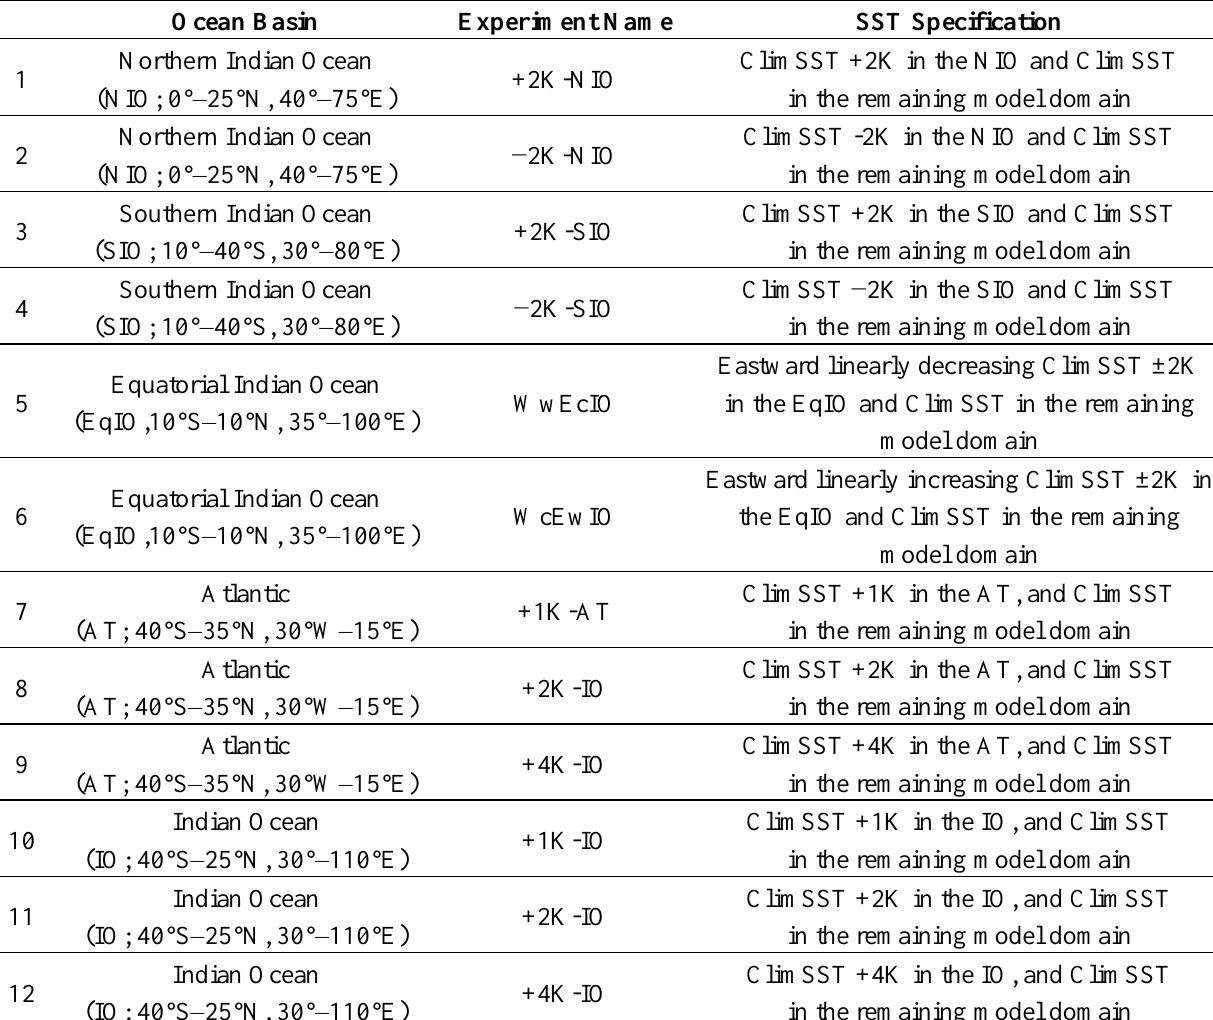
Table 1. List of sea surface temperature (SST) sensitivity experiments. ClimSST is the 1971–2000 climatological SST. Six-hourly and daily varying 30-year atmospheric climatologies obtained from the NCEP/NCAR Reanalysis data set provided initial and lateral boundary conditions for all